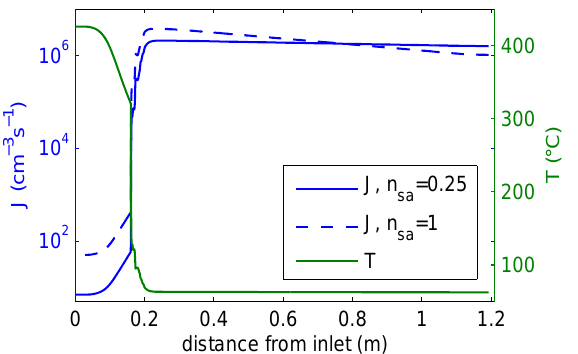
Figure 7. Temperature and nucleation rate at the axis when there is [ H ] = 1 . 47 × 10 11 cm − 3 in raw exhaust of R case with differ- 2 SO 4 ent nucleation exponents.